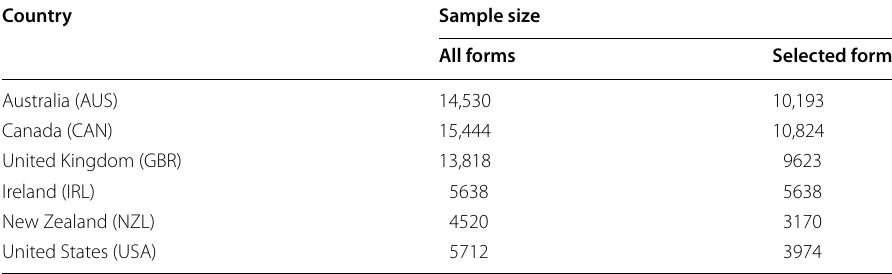
Table 1 Country sample size Country Sample